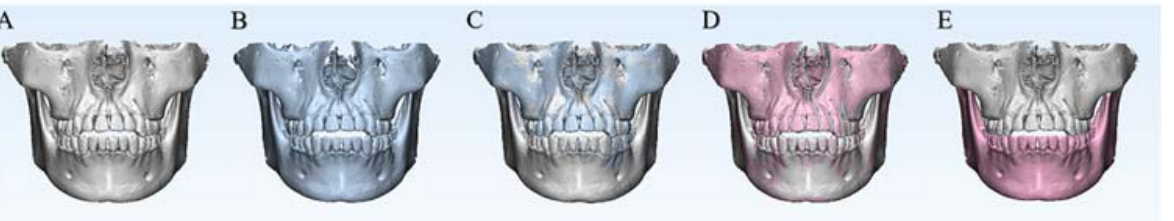
After mandibular voxel-based superimposition, the mandibular positional changes